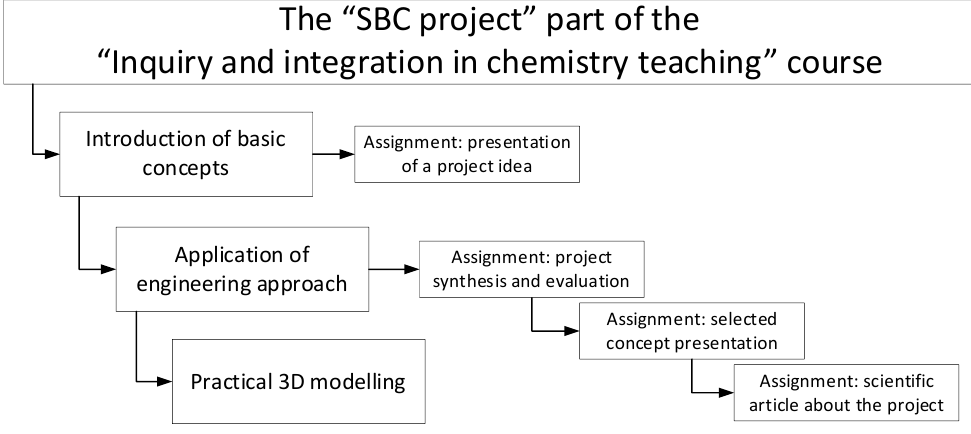
Figure 4. The flow chart of the “SBC project” part of the course